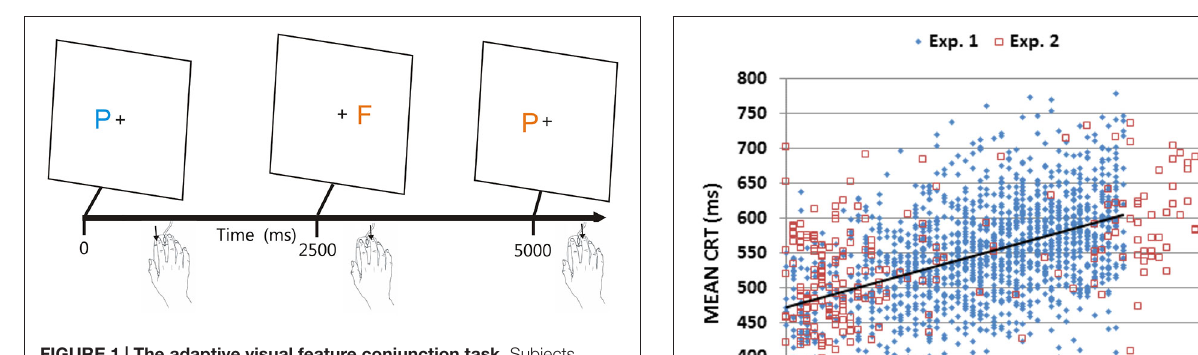
FIGURE 1 | The adaptive visual feature conjunction task . Subjects performed a visual feature conjunction task with colored letters (blue P, blue F, orange P, or orange F) subtending 0.5 ◦ of visual angle randomly presented to the left or right hemifield, 1.6 ◦ from the fixation cross. Stimulus durations were 200 ms. Right-handed subjects pressed the left mouse button for targets (blue P’s, probability 40%) and pressed the right mouse button for non-targets, i.e., letters which resembled the target in color, shape, or neither feature (probability 20% each). Stimuli could occur ipsilateral (trials 1 and 2) or contralateral (trial 3) to the mouse button used for responding. Stimulus onset asynchronies (SOAs) were initially set at 2500 ms and were either reduced by 3% following each pair of successive hits or increased by 3% following each miss.